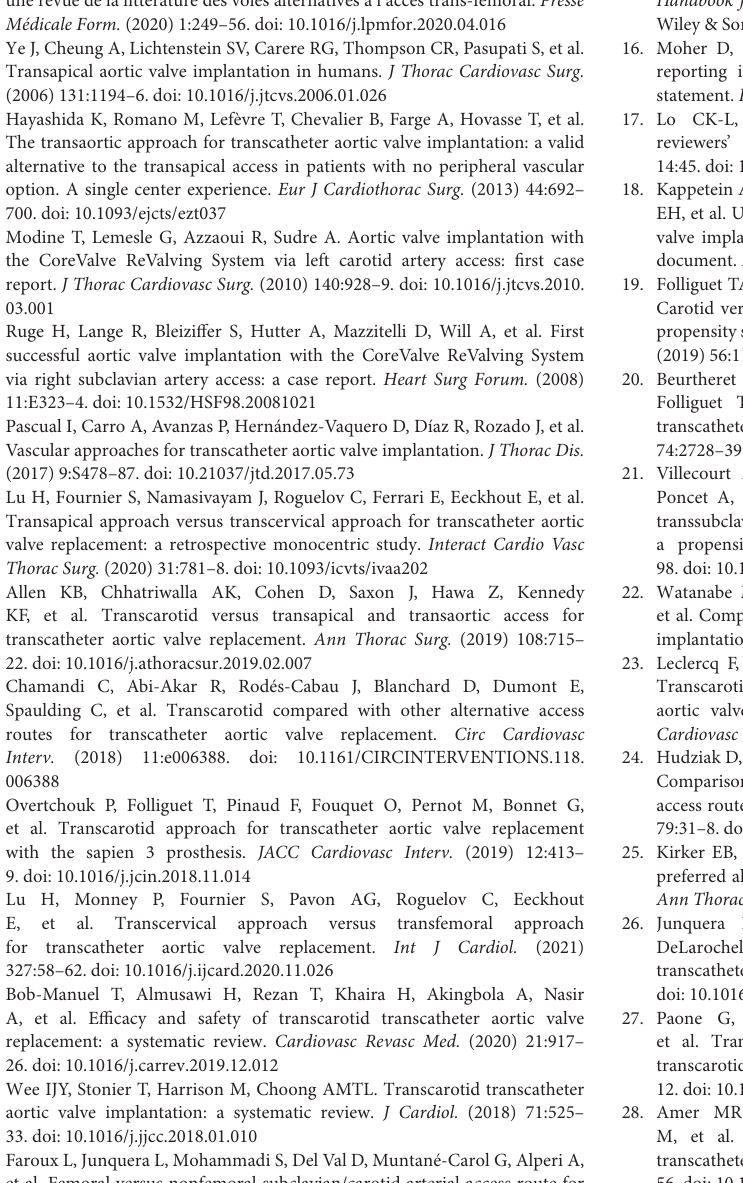
Supplementary Table 2 | Quality of assessment using the Newcastle-Ottawa Scale. Supplementary Table 3 | Technical aspects of transcarotid transcatheter aortic valve implantation procedures. Supplementary Table 4 | Type of prosthesis used according to TAVR